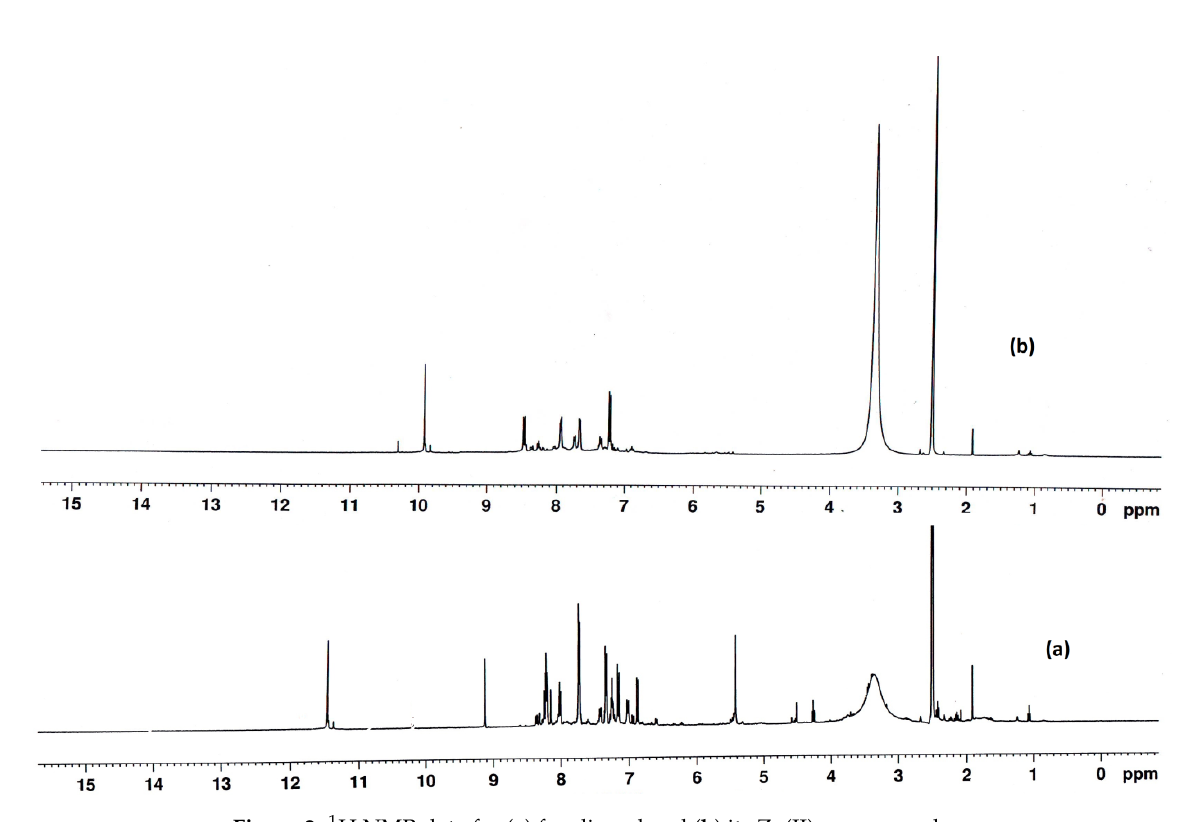
Table 1. Elemental analysis and some physical measurements of free ligand and its metal nano complex. Compd. No. Empirical Formula